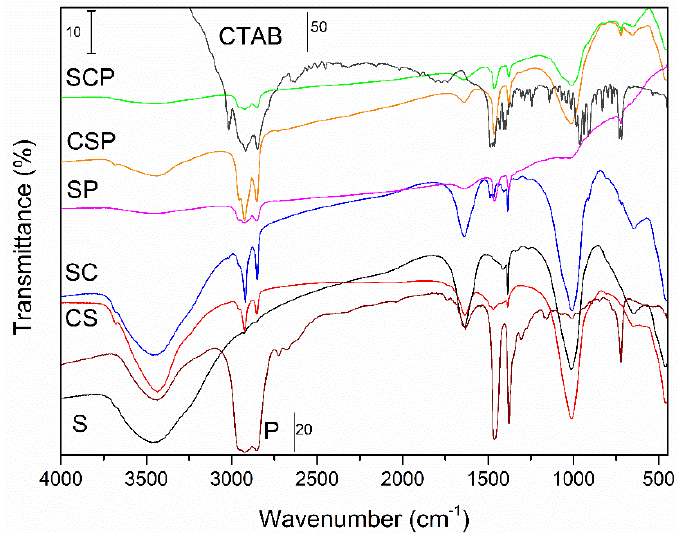
Figure 2. FT-IR spectra of the synthesized solids, and those of the paraffin (P) and CTAB as refer-